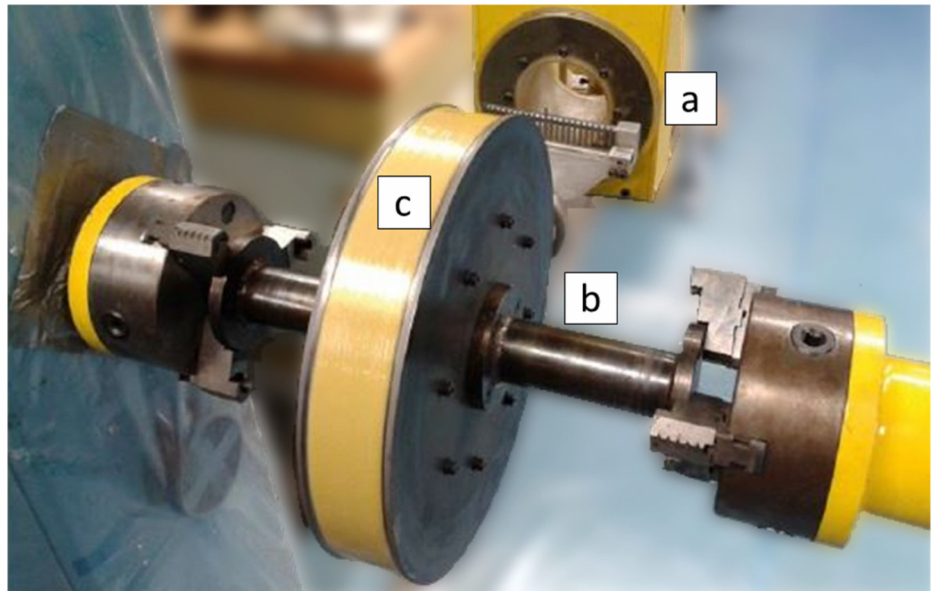
Figure 2. Composite flywheel rotor rim at the end of filament winding manufacturing process; ( a ) fiber payout eye and deposition head on winding machine carriage arm, ( b ) winding mandrel, and ( c ) completed aramid fiber/epoxy composite